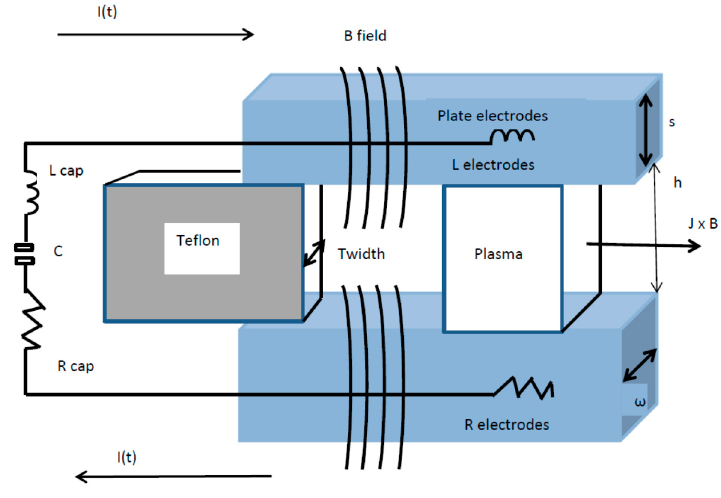
Figure 38. Pulsed Plasma Thruster Model [4].